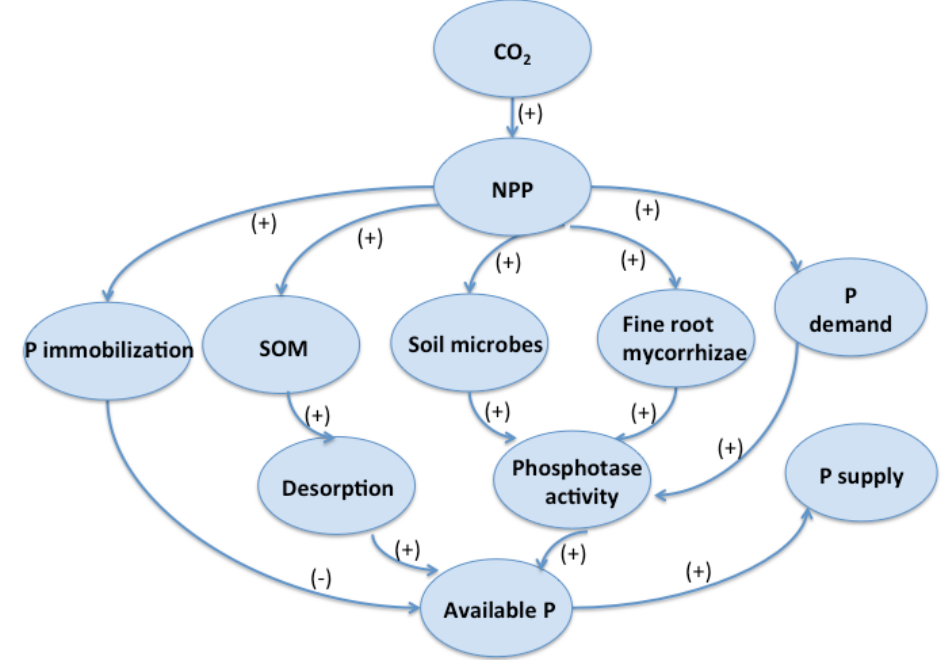
Fig. 6. Feedback loops between C and P cycles that affect tropical ecosystem responses to elevated [CO 2 ]